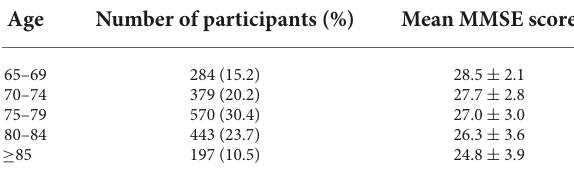
FIGURE2 Flow chart detailing the derivation of the study sample.